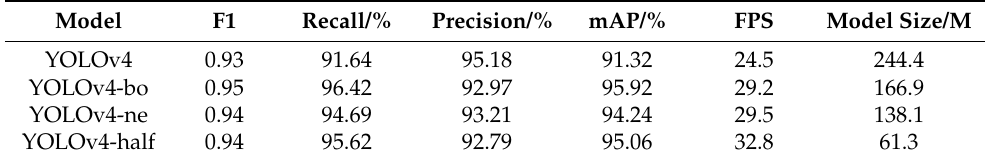
Table 1. Comparison table of width experiment.